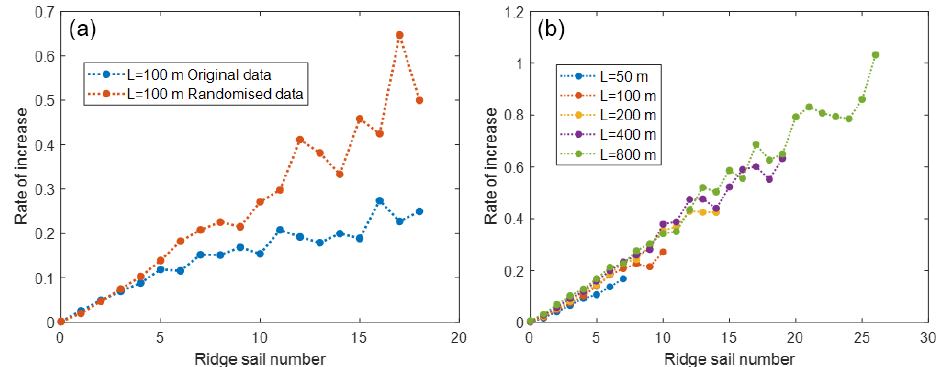
Figure 2. Sail number increase rate for a threshold process with target threshold 0.5m. (a) Rate for observed sail heights and randomised sail heights for segment length L = 100m. (b) Rates for randomised sail heights for different segment lengths.